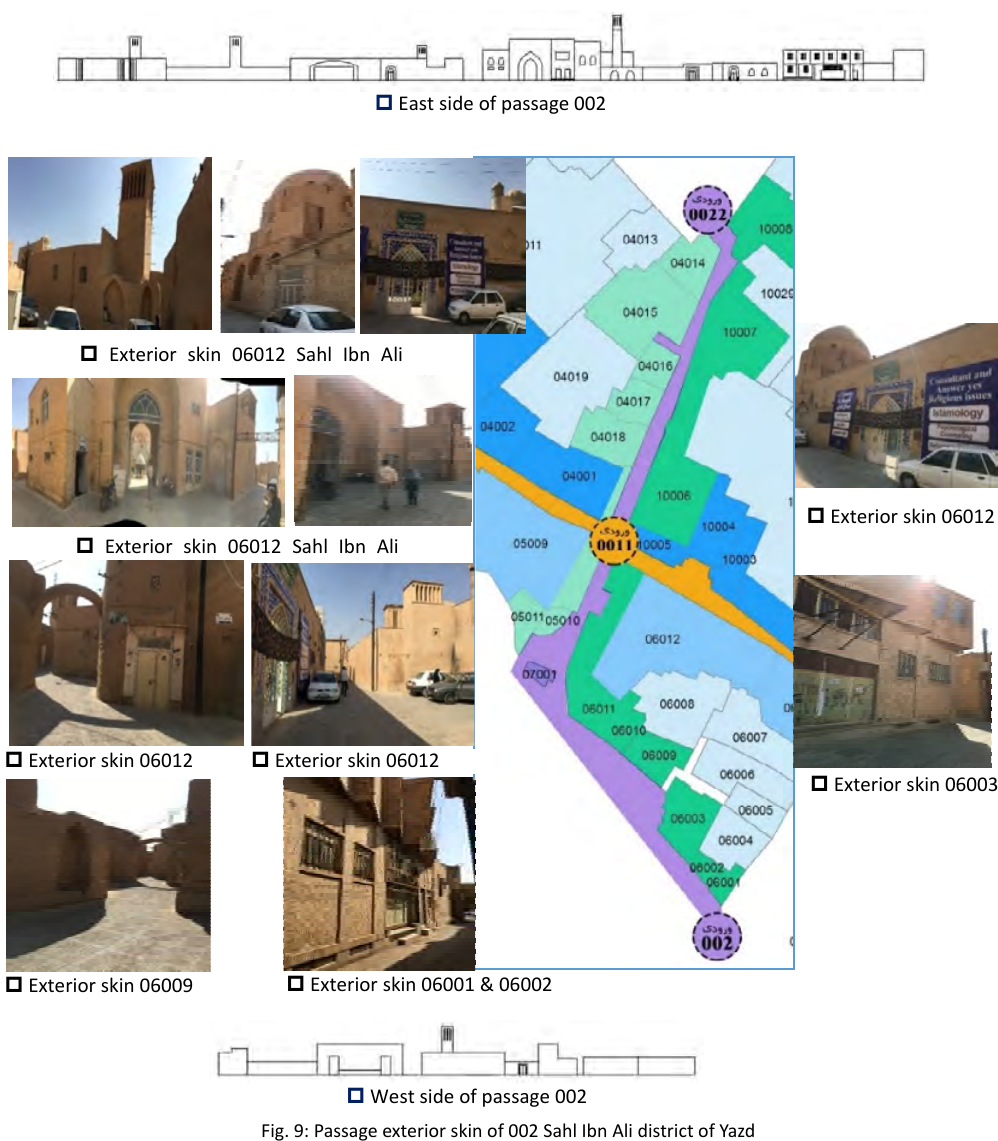
Fig. 9: Passage exterior skin of 002 Sahl Ibn Ali district of Yazd Table 2: Summary of the proportions of Sahl Ibn Ali exterior skin district of Yazd Average height of district entrance